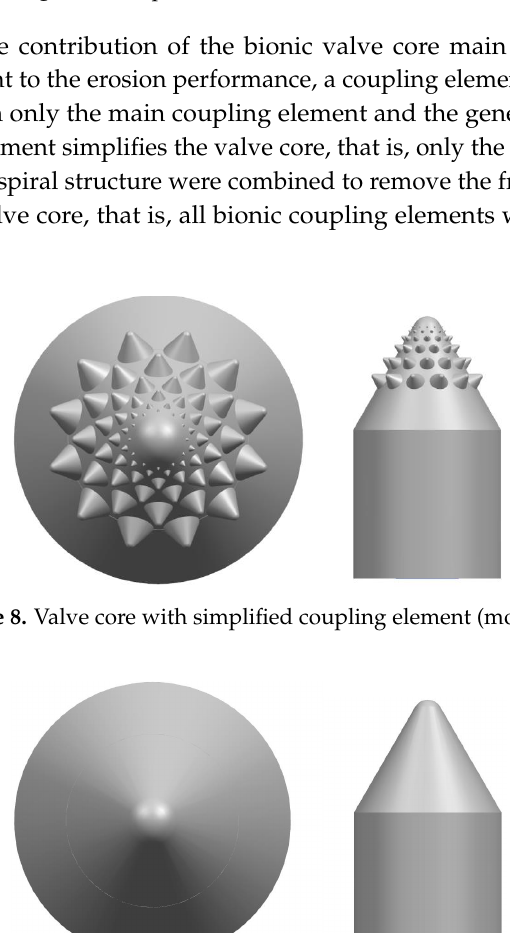
Figure 7. Simplified bionic valve core (model C).